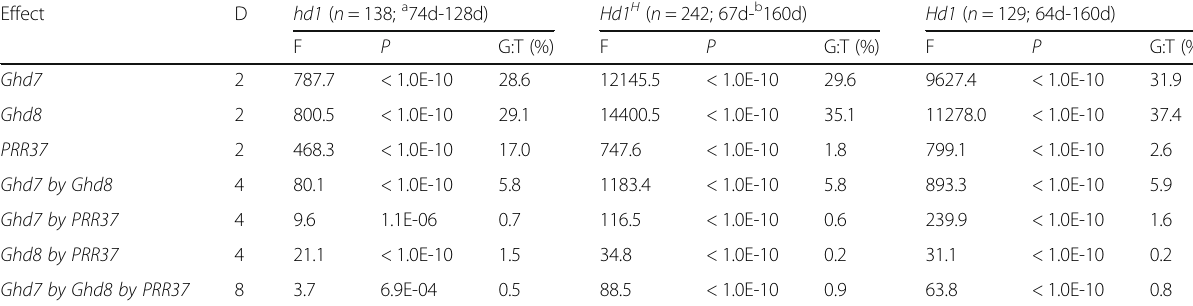
Table 1 Three-way ANOVA analysis of Ghd7 , Ghd8 and PRR37 in NIL-F 2 population under NLD conditions Effect